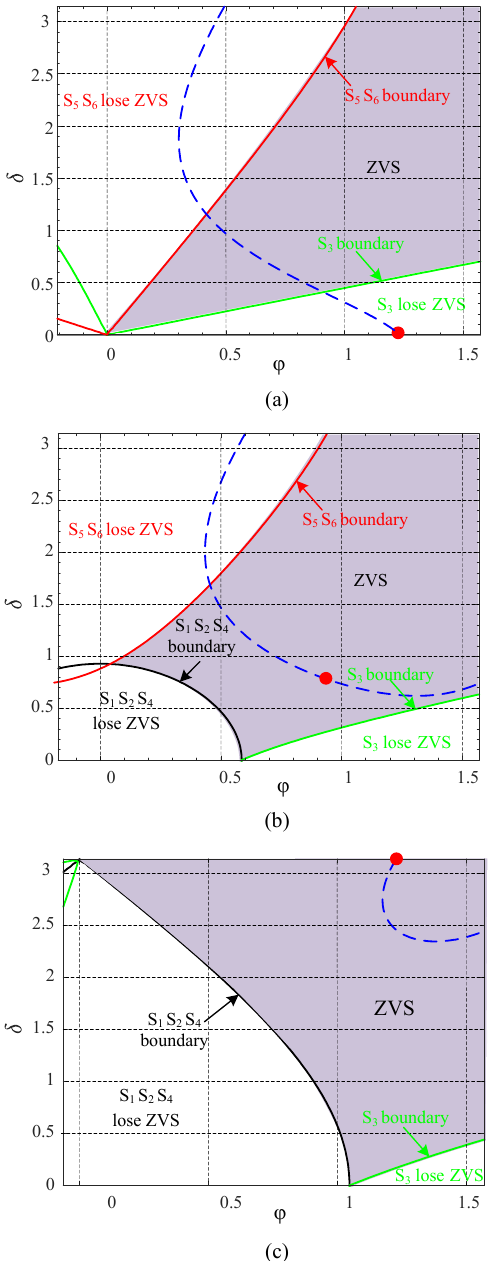
Figure 10. ZVS Region with different voltage gains: ( a ) M = 0.5, ( b ) 0.5 < M < 1, ( c ) M =